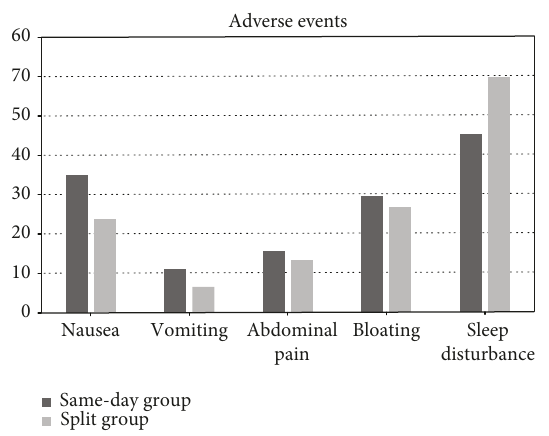
Figure 5: Distribution of adverse events in the same-day and split group, expressed as